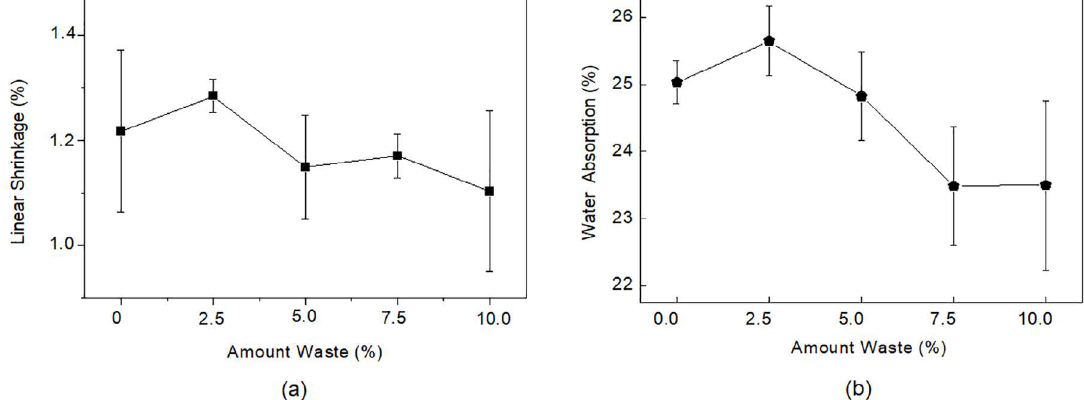
Figure 6. Linear shrinkage (a) and water absorption (b) of different ceramic compositions.